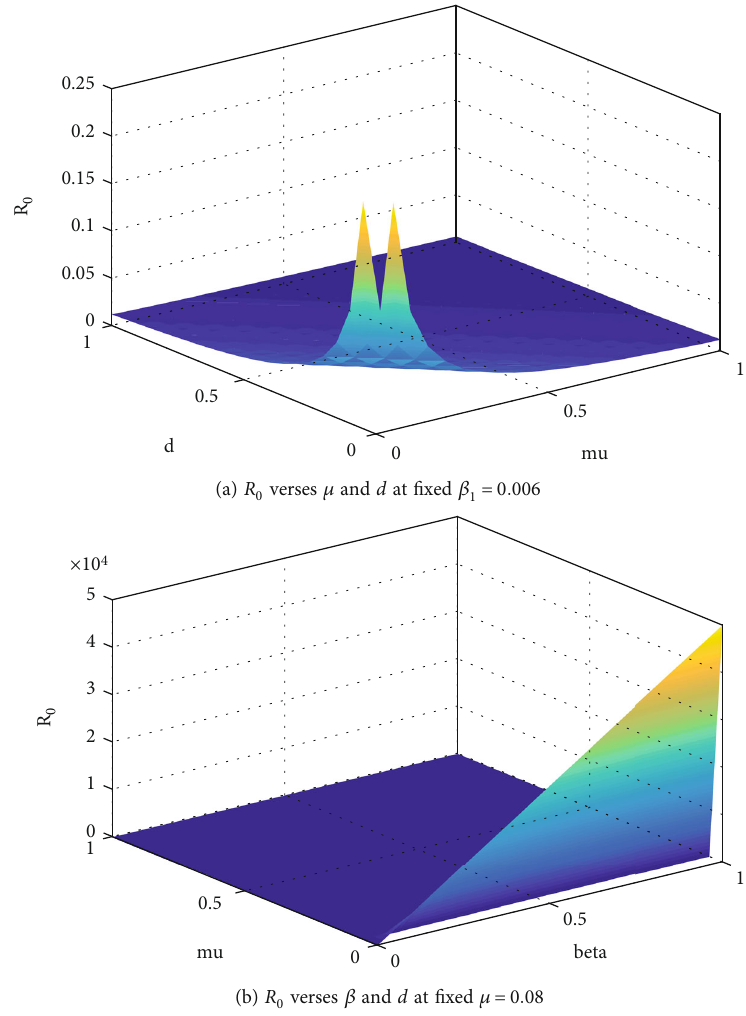
Figure 1: Sensitive parameters β , μ , and d and its impact on R